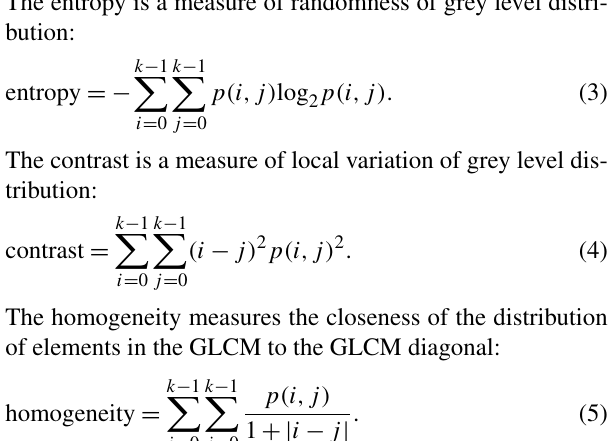
Figure 4. The mask of the whole-sky images. The area within the circle is the ROI, and the area outside the circle is not the ROI.